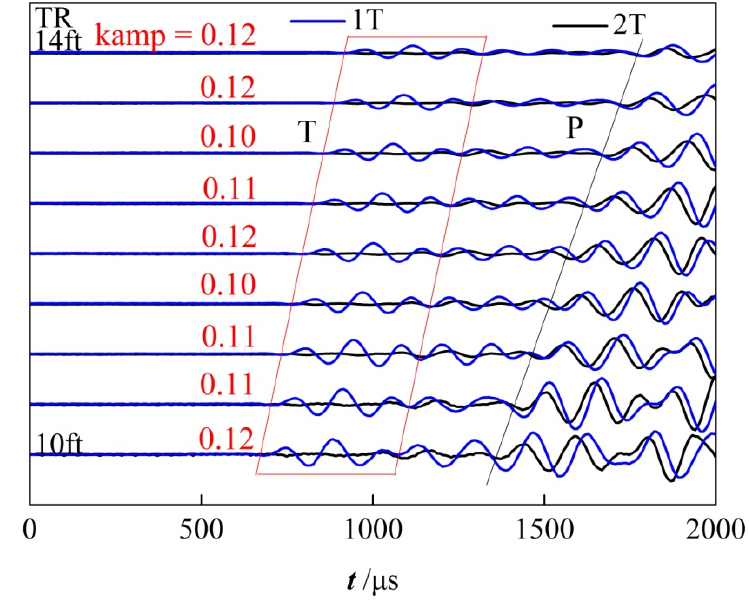
Figure 8. Waveforms are collected by eight receiving transducers at a certain depth, which are excited by single-source (blue) and dual-source (black), respectively.